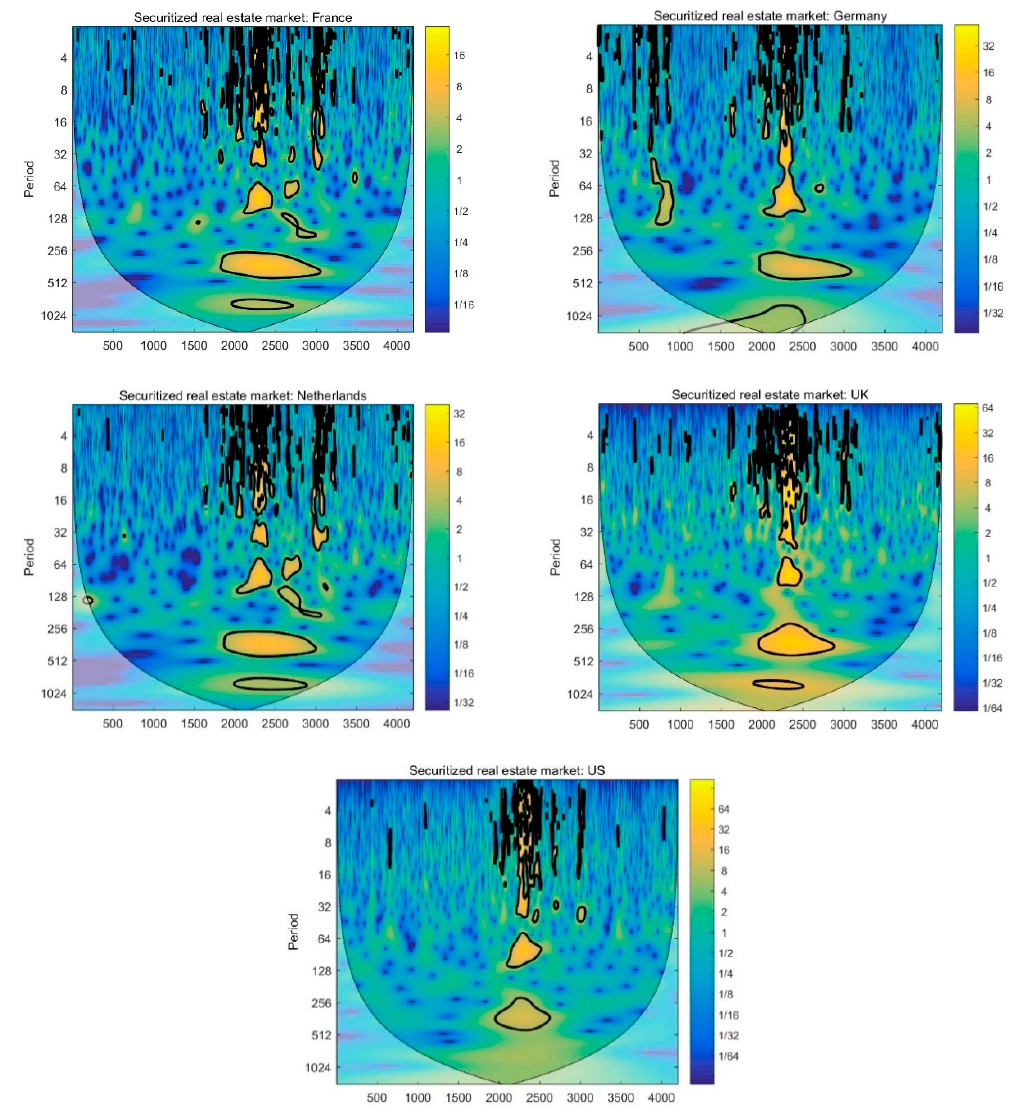
Figure 1. Wavelet power spectrum for securitized real estate market indexes. Notes: Contours are for the wavelet spectrum. The color bar on the right-hand-side of each graph ranges from low power spectrum (dark blue color) to high coherency (yellow color). The thick dark lines indicate the 5% significant level for wavelet coherencies.